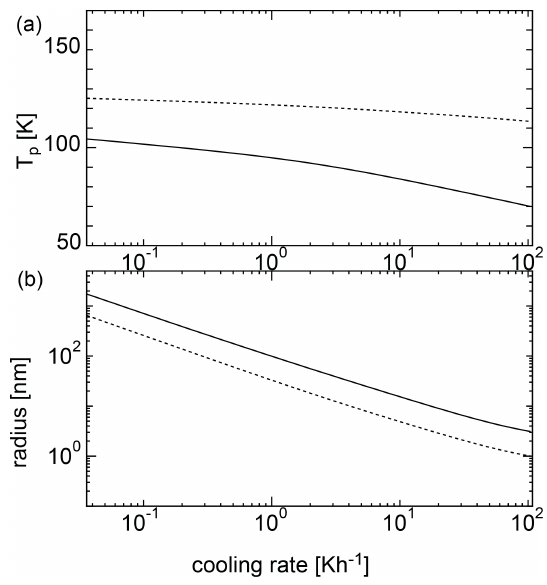
Figure 5. The same as Fig. 4 but for an initial temperature of